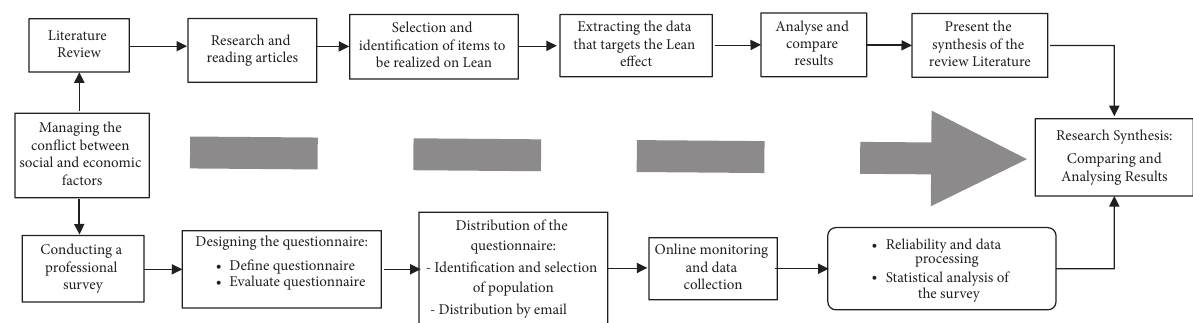
Figure 5: The research design